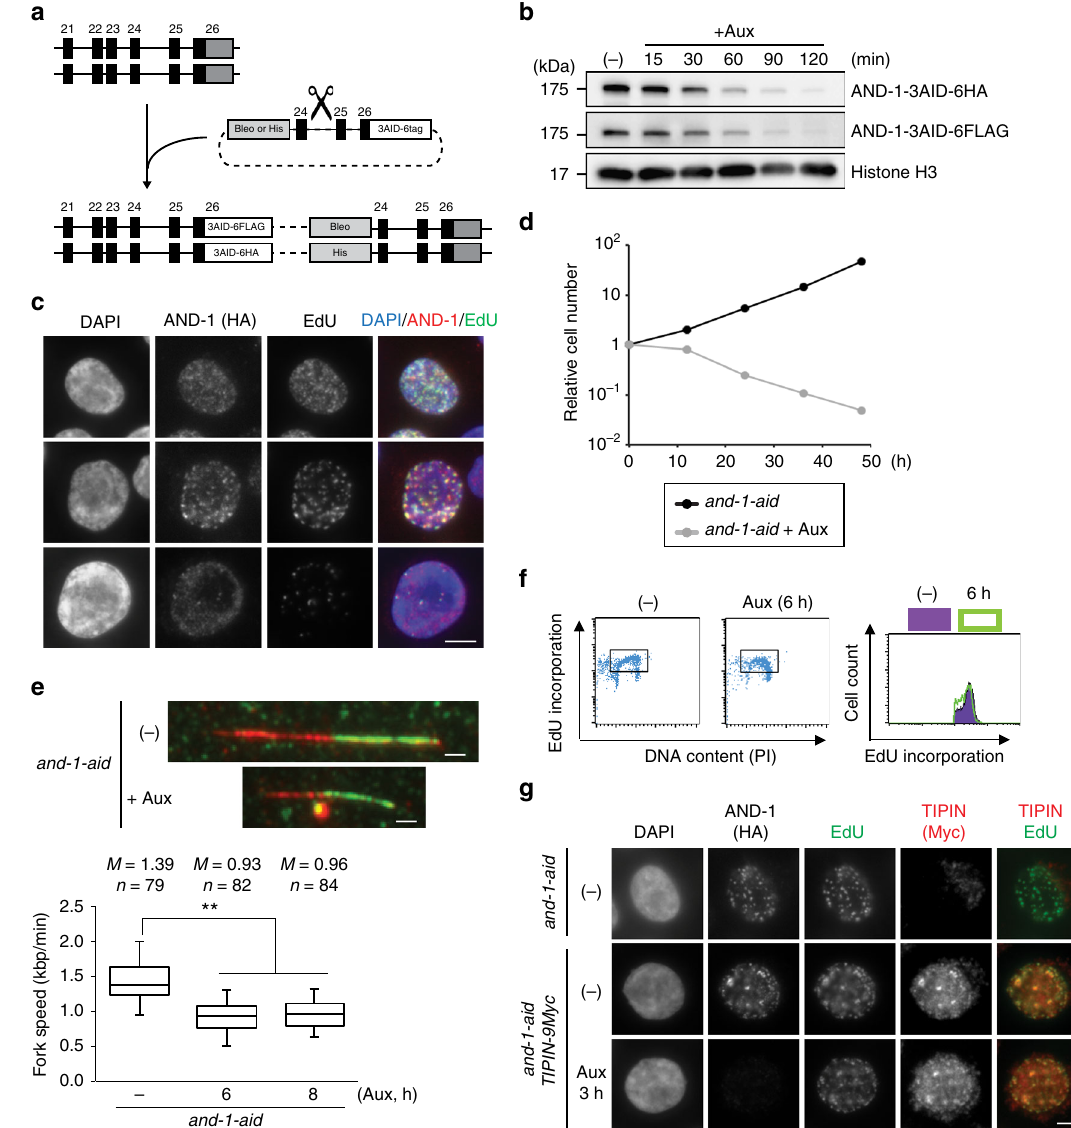
Fig. 1 Establishment and characterization of AND-1 depletion in DT40 cell lines. a Schematic representation of the AND-1 gene locus and fl ip-in constructs. Black boxes indicate exons, “ Bleo ” and “ His ” indicates drug resistance markers. b Total cell lysates were prepared from and-1-aid cells expressing AND-1-3- AID-6FLAG and AND-1-3AID-6HA, which were analyzed by Western blotting at the indicated time points. c and-1-aid cells were incubated with EdU for 15 min, and replication foci (marked by EdU) and AND-1 foci were visualized by Click-iT method and immunostaining with HA antibody, respectively. Scale bar represents 5 μ m. d Growth curves of and-1-aid cells. 10 5 cells were inoculated in 1mL of medium and passaged every 12 h. e and-1-aid cells were cultured with or without auxin for indicated times, and DNA replication elongation rates were determined from the lengths of CldU tracks (only the ones clearly connected with IdU tracks were considered). Scale bar on the representative fi ber image represents 5 kb. Middle line = median; box = 25th and 75th percentiles; bars = 5th and 95th percentiles. M indicates median values, n , the number of fi bers analyzed in each condition. P values were calculated by Student ’ s t -test and ** P ≤ 0.01. f Cell cycle distribution of AND-1 depleted cells. and-1-aid cells were incubated with auxin for 6 h, pulse-labeled with EdU for 15 min, and harvested. The cells were stained with Alexa488 azide to detect EdU uptake and with PI to detect DNA. Left panels show EdU uptake on the y -axis, and total DNA on the x -axis. Right panel shows cell number on the y -axis, and EdU uptake on the x -axis. g and-1-aid and and-1-aid TIPIN-9Myc cells were processed as in ( c ), with the addition of auxin treatment for 3 h, to monitor EdU, AND-1 (anti-HA), and Tipin (anti-Myc) foci. Scale bar represents 5 μ